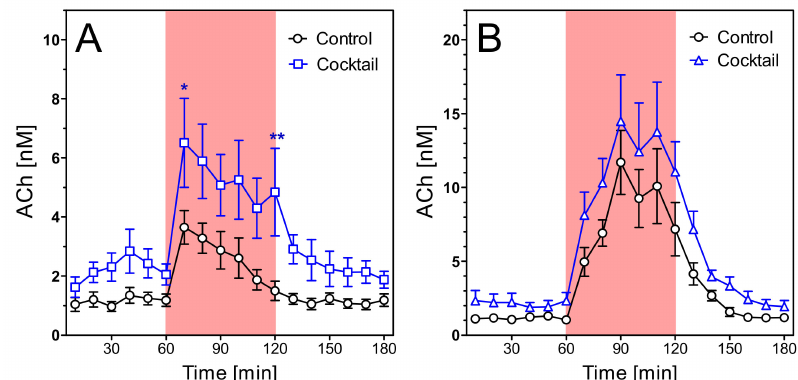
Figure 12. Extracellular ACh concentrations in hippocampus of 15–16 months old transgenic rats during open field test ( A ) and during scopolamine perfusion ( B ). The rats were submitted to two different treatments: no treatment (“control”) and cocktail. The red area represents the intervention (open field exposure or scopolamine perfusion) from 60–120 min. Data are means ± SEM ( n = 8) and were analysed by two-way ANOVA for treatment as variable followed by Bonferroni’s multiple comparison test: ( A ) F1,238 = 4.90, p = 0.04. ( B ) F1,238 = 2.47, p = 0.14. *, p < 0.05; **, p < 0.01.